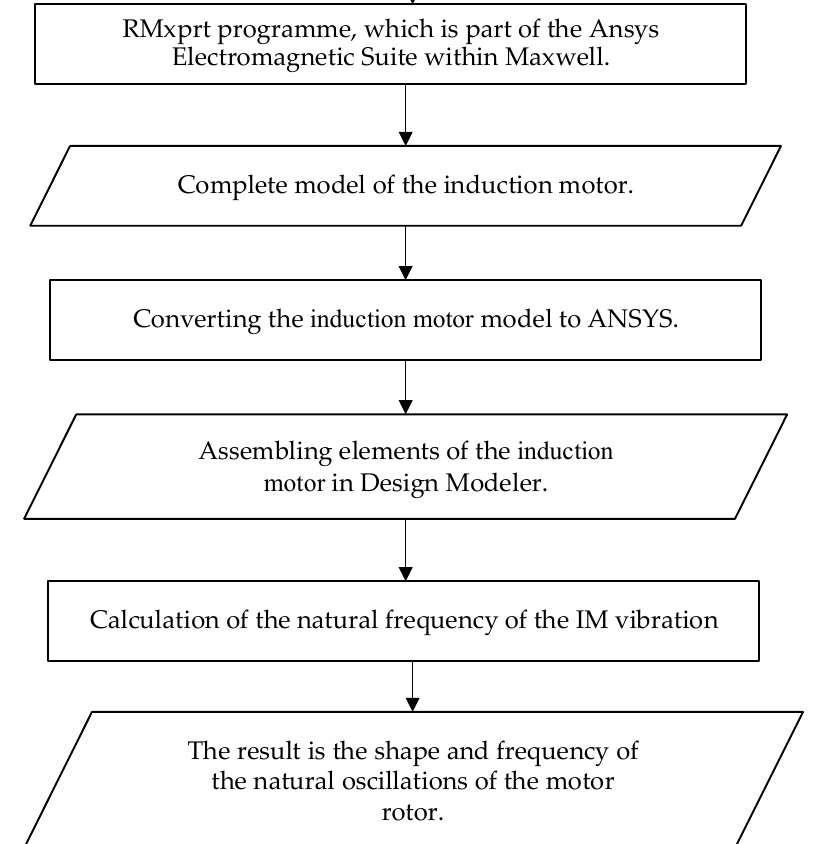
Figure 2. A diagram of information flow when designing the asynchronous motor.